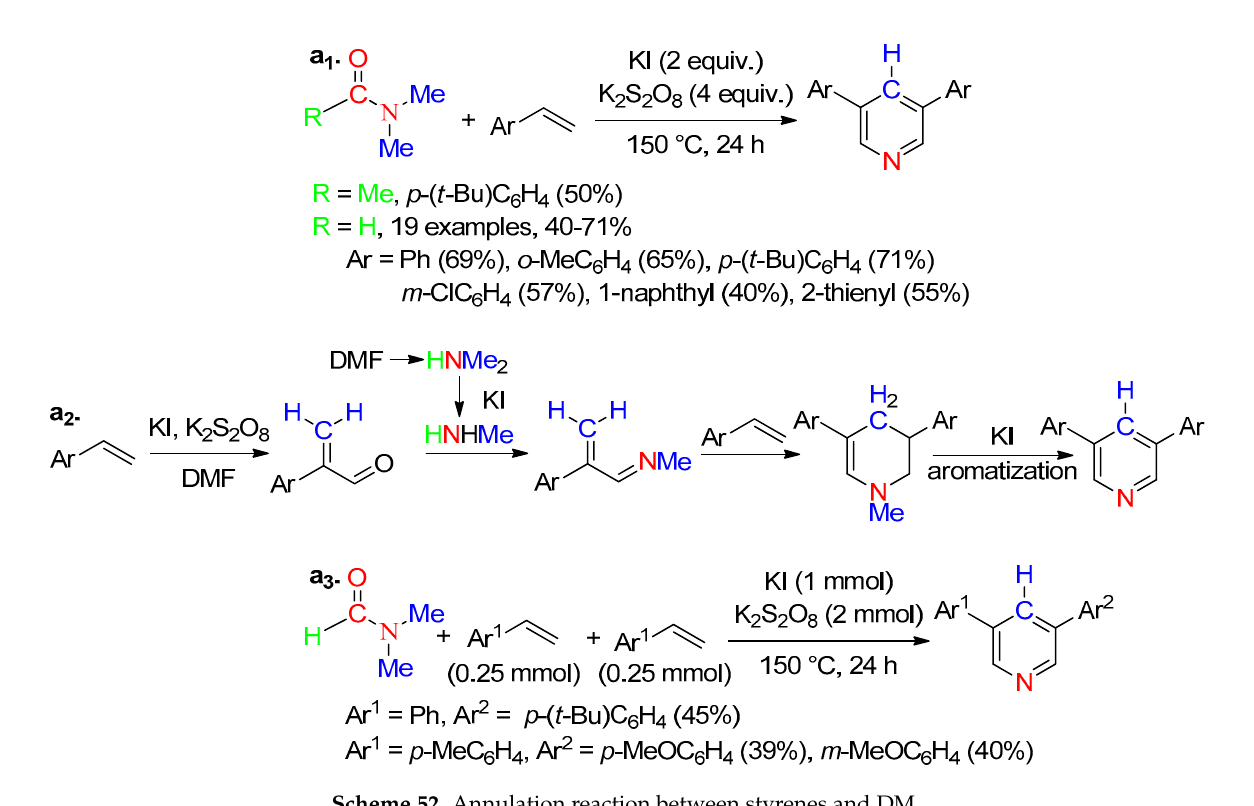
Scheme 52. Annulation reaction between styrenes and